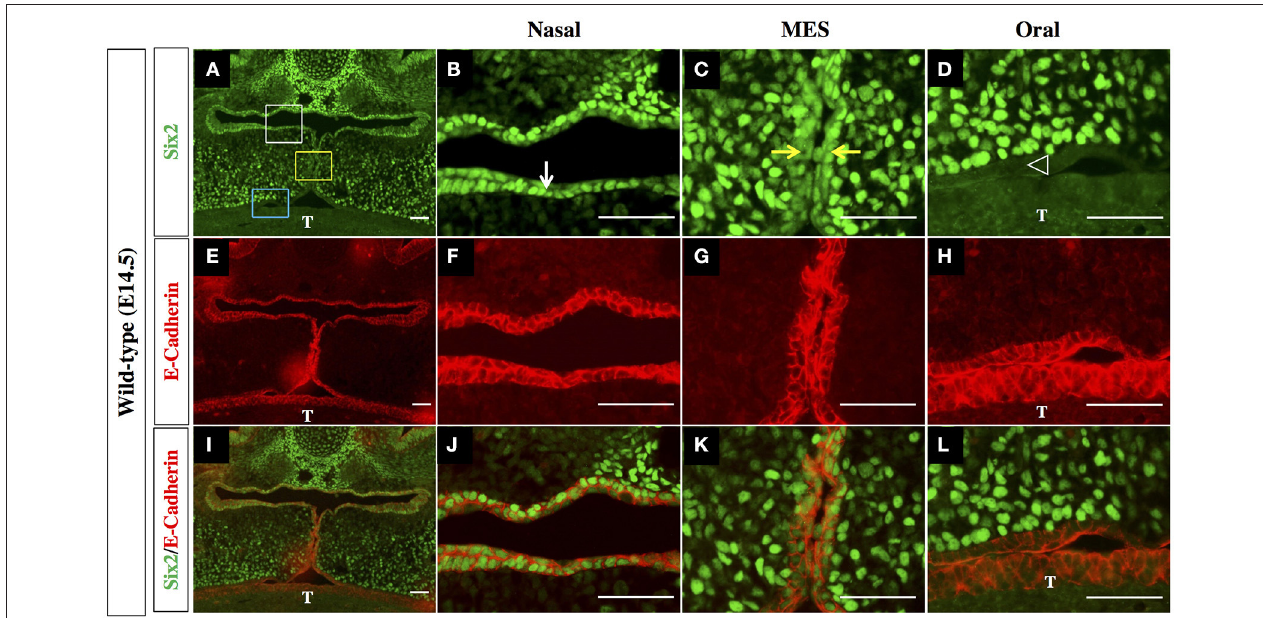
FIGURE 3 | Six2 protein is differentially expressed by epithelium on the nasal side vs. the oral side of the palatal shelf in wild-type mice. IHC staining of mid-coronal sections of wild-type palatal shelves at E14.5 for Six2 (A–D) and E-Cadherin (E–H) . Panels I-L are the Six2 immunofluorescence images overlaid with the E-Cadherin immunofluorescence images to identify cells co-expressing the two proteins. Six2 protein expression is prominent in epithelial cells located on nasal side of the palatal shelf (marked by the white rectangle in panel (A), and by the white arrow in panel (B), where it is co-expressed with the epithelial marker E-cadherin (E,F,I,J) . Six2 is also expressed in epithelial cells of the MES (marked by yellow rectangle in panel A, and by yellow arrows in panel (C), which is the point of contact between the apical tips of the two elevated palatal shelves. In contrast, Six2 protein is absent from the epithelium on the oral side of the palatal shelf [marked by the blue rectangle in panel (A) and by position of the arrowhead in panel (D) ], which expresses E-cadherin alone (E,H,I,L) . MES, midline epithelial seam; T, tongue. Scale bars, 50 µ m. The IHC staining images shown are representative of palatal sections from a minimum of 5